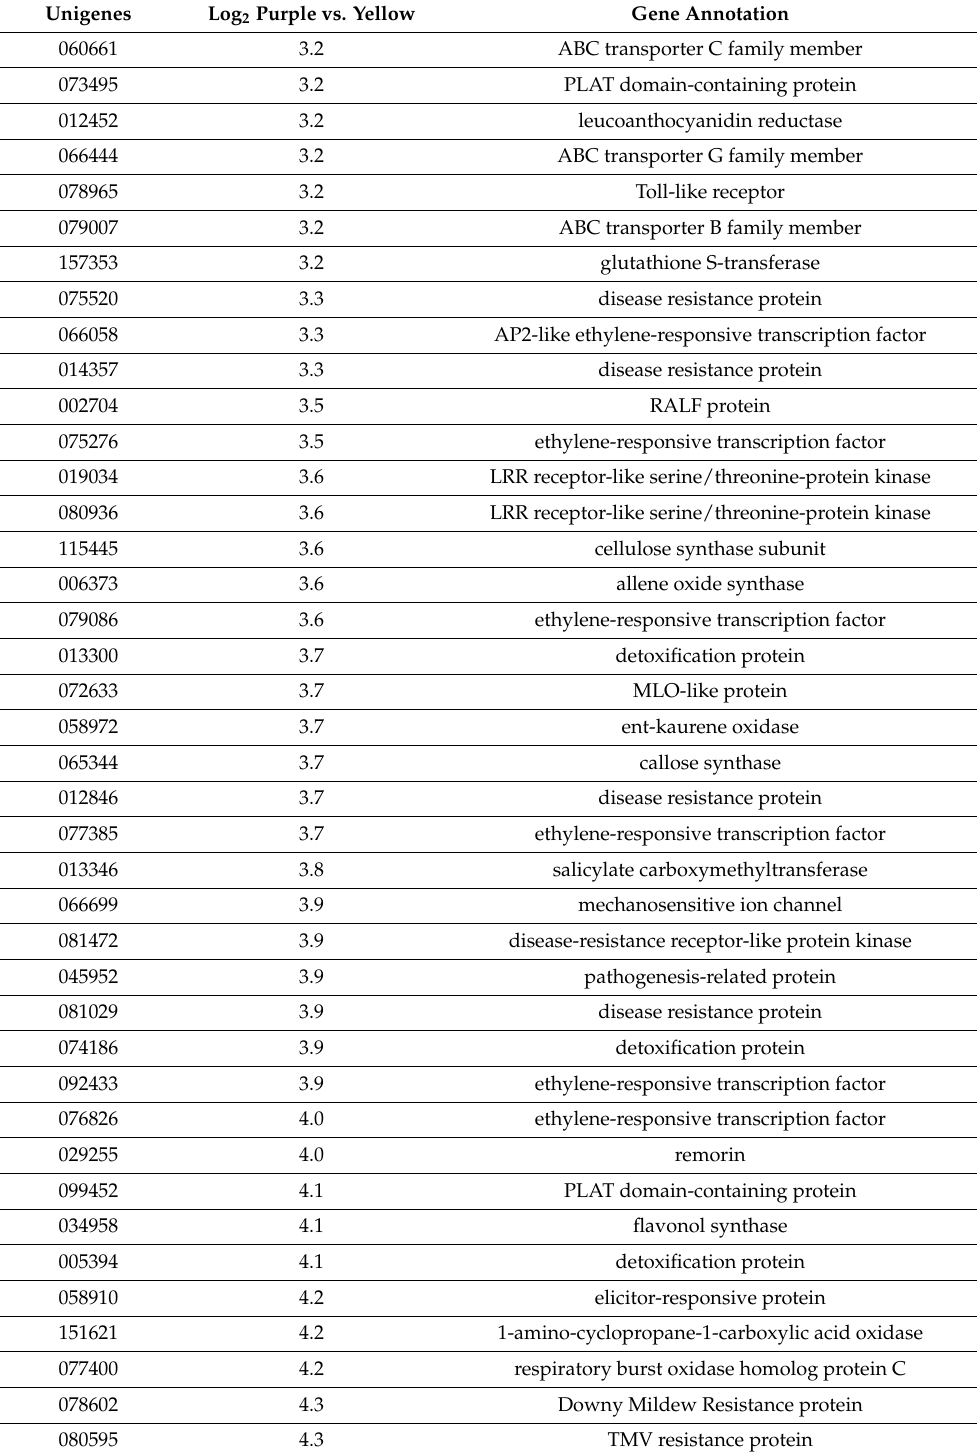
Table 5. Genes involved in various protection mechanisms with higher expression in the peels of the purple fruit in comparison to the yellow fruits. The data are based on three independent